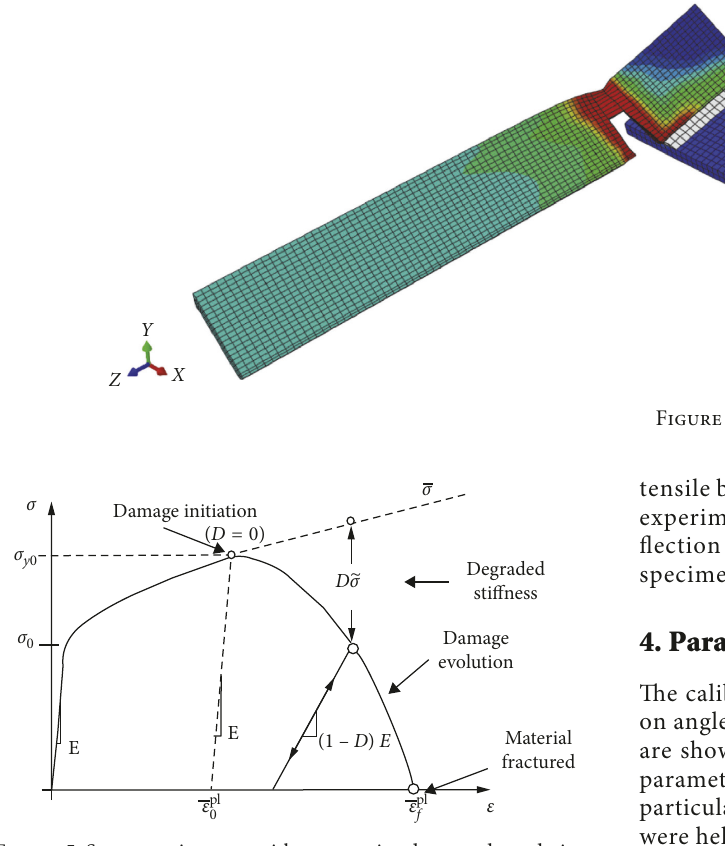
Figure 5: Stress-strain curve with progressive damage degradation, ABAQUS